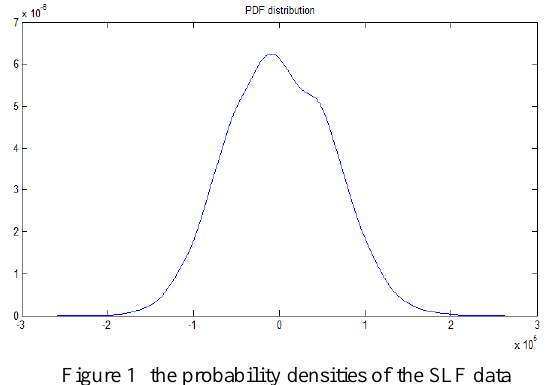
Figure 1 the probability densities of the SLF data